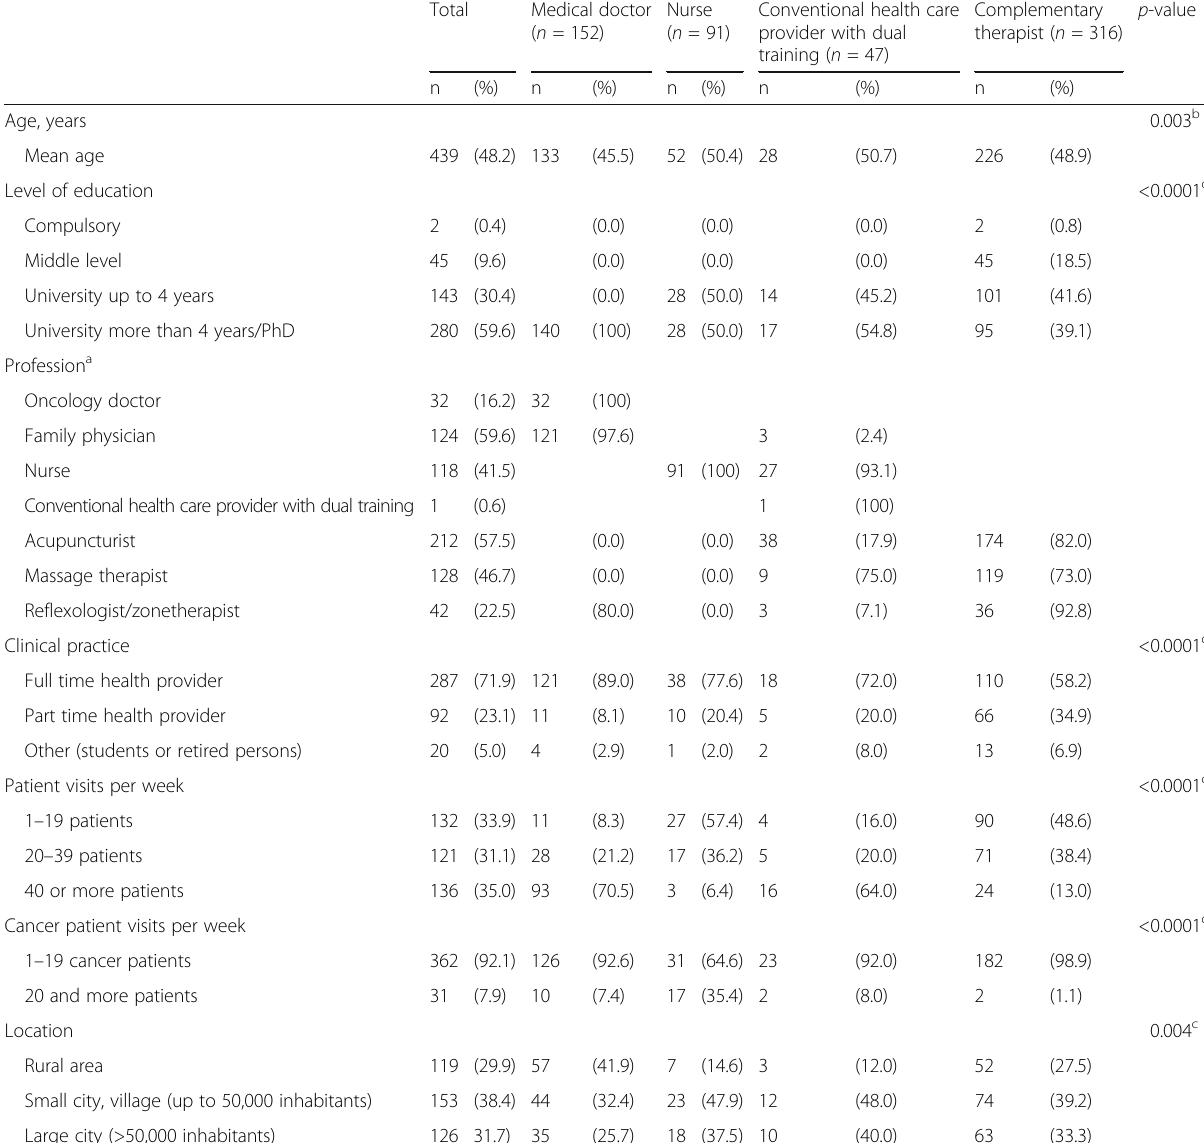
Table 3 Characteristics of the participants ( n = 606)